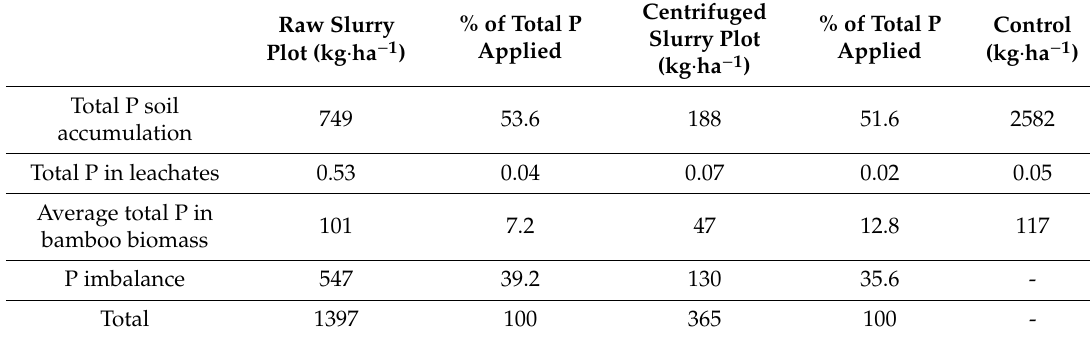
Table 5. Phosphorus balance between the bamboo biomass, soil and